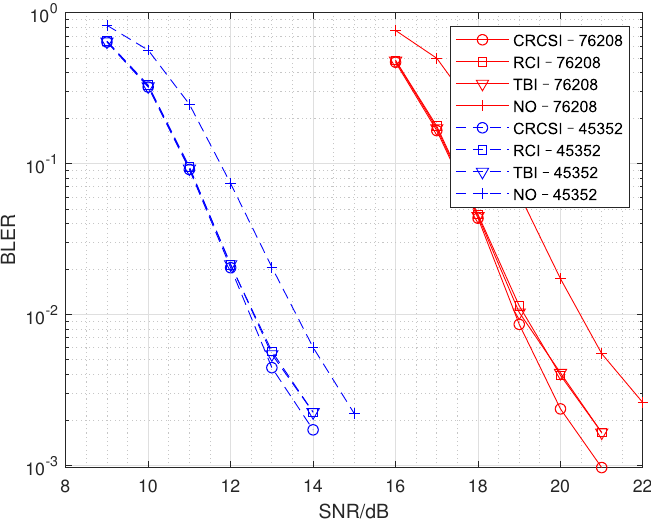
Figure 5. Comparison for fixed reception.